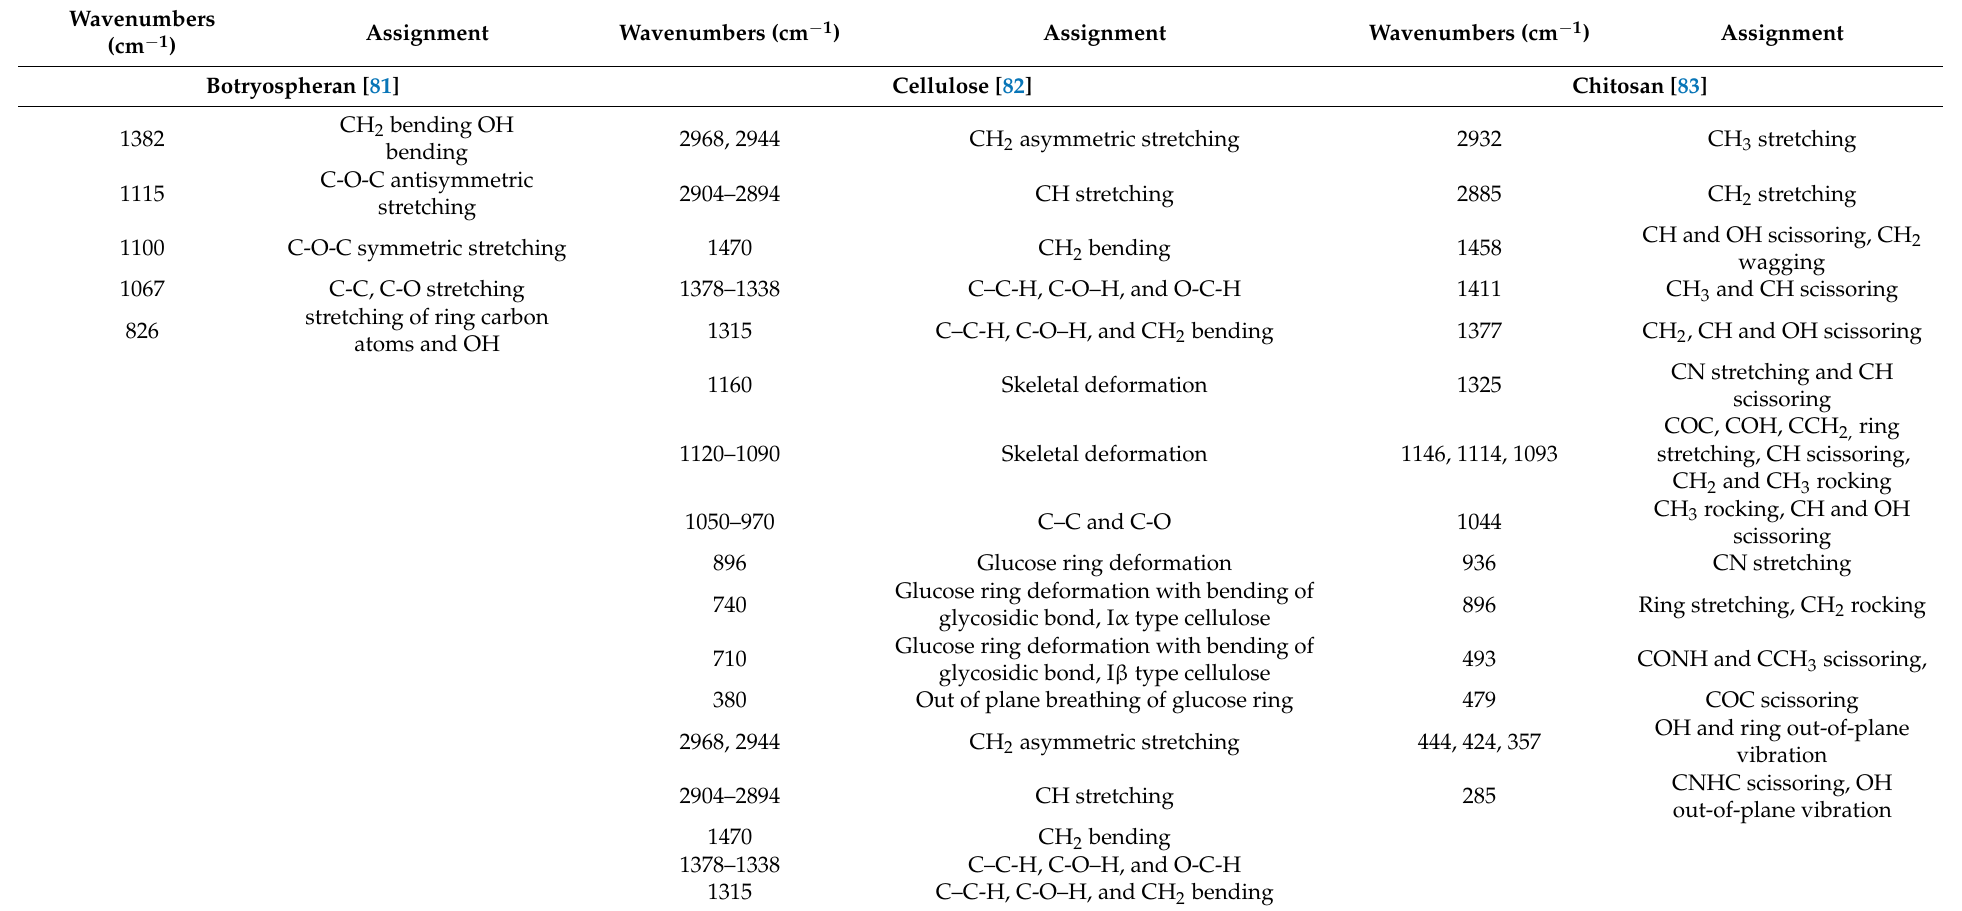
Table 2. The most important bands obtained in the Raman spectra of described